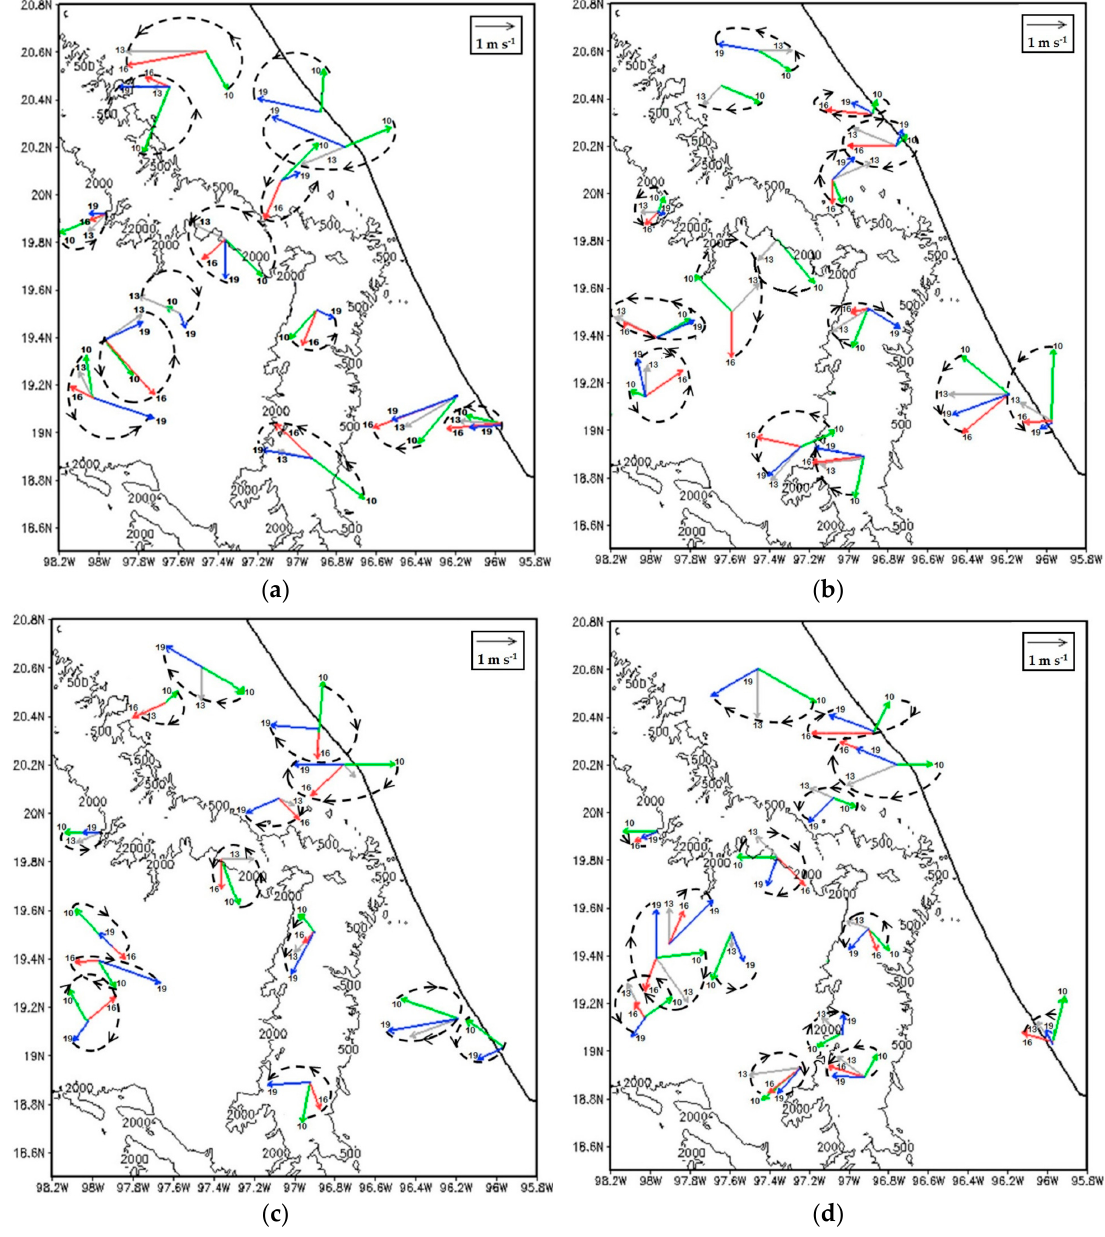
Figure 10. Surface wind observations (m s − 1 ). The numbers at the end of the vectors indicate the local time, for the days ( a ) June 29, ( b ) June 30, ( c ) July 1, and ( d ) July 2, 2015. The intensity scale is located in the upper left corner. The contours of 500 and 2000 m.a.s.l. are shown.